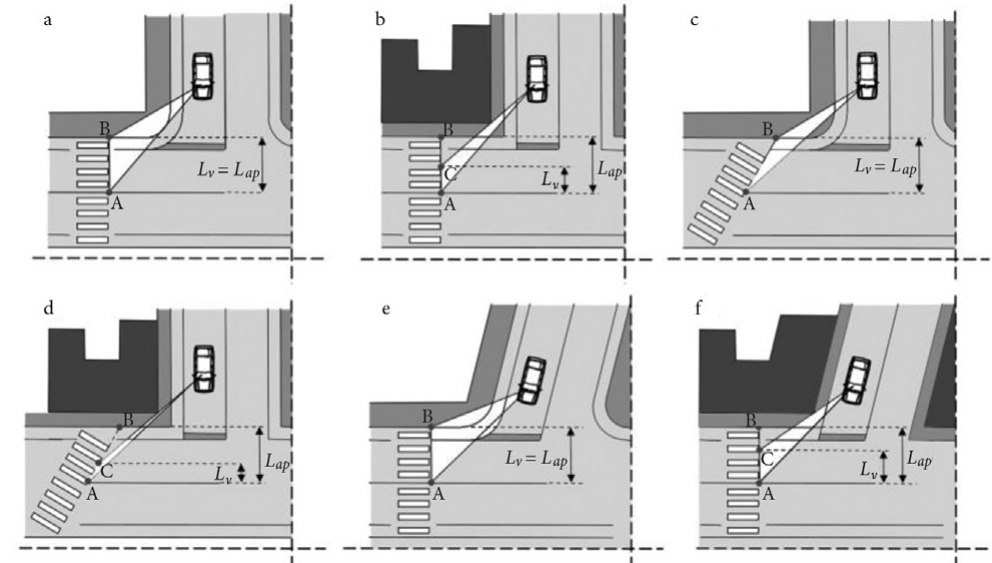
Fig. 2. Conditions of visibility between pedestrians and vehicles in the road intersections Table 5. Adjustment factor to visibility conditions Reference